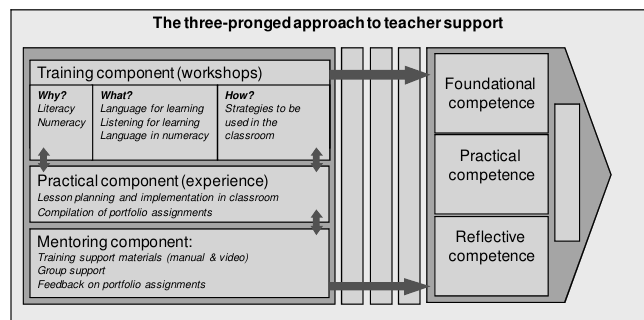
Fig. 1. A model of the CPD programme for foundation-phase educators.